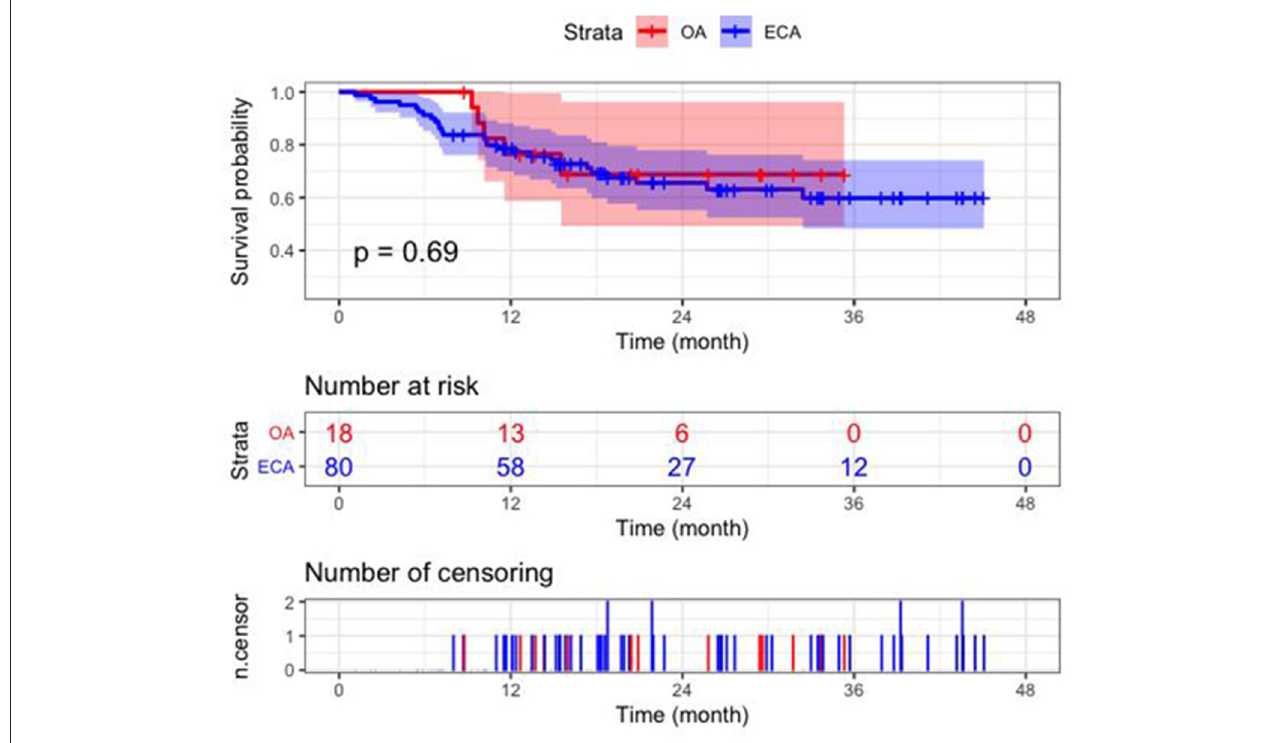
FIGURE 2 | Kaplan–Meier estimates of ocular survival in the OA group and ECA